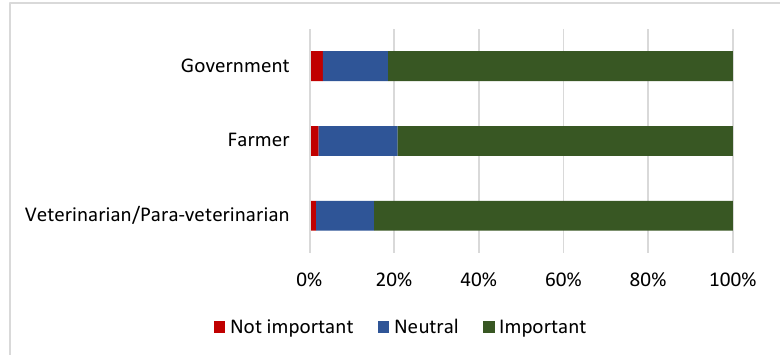
Figure 3. Respondents’ opinion on the roles of different actors in monitoring the responsible use of antimicrobials in broilers ( n = 509) .